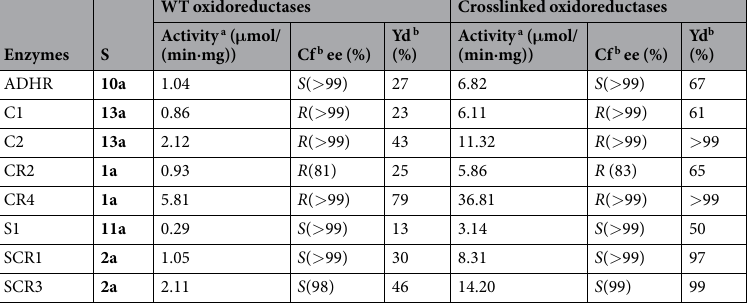
Table 3. Specific activity and stereoselective efficiency of WT oxidoreductases and crosslinked oxidoreductases toward their favorite substrates. a Standard assay conditions: 100 mM phosphate buffer (pH 7.0), 0.5 mM NADPH, 5 mM substrate, 1 mg/mL enzymes at 35 °C. The data was the representative of three independent experiments and standard errors were not more than 5%. b The biotransformation was conducted with 5 g/L substrate and sufficient NADPH for 6